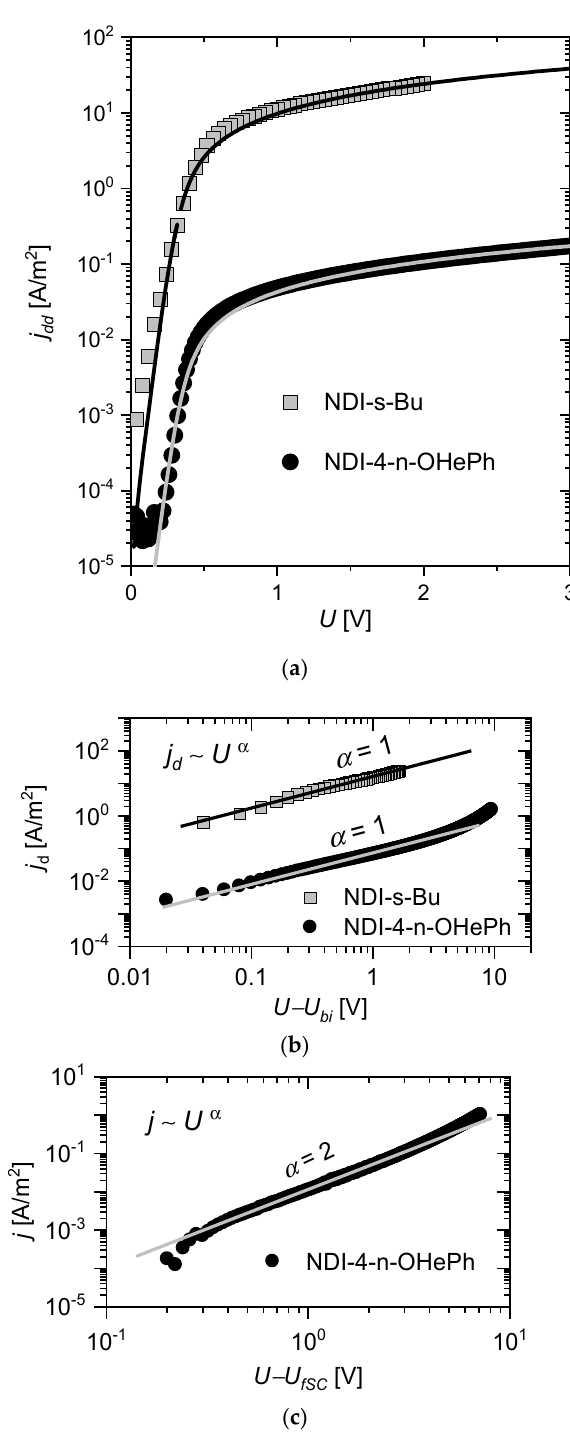
Figure 3. Current-voltage characteristics for electron-only devices based on naphthalene diimides NDI-s-Bu and NDI-4-n-OHePh. The straight lines mark the best fit of the driftdiffusion current model to the current-voltage characteristics ( a ); drift current for bias higher than built-in voltage U bi ( b ); space-charge-limited current in NDI-4-n-OhePh for bias higher than U fSC voltage ( c ). The slope of the characteristic to the abscissa (straight lines) ( b , c ).